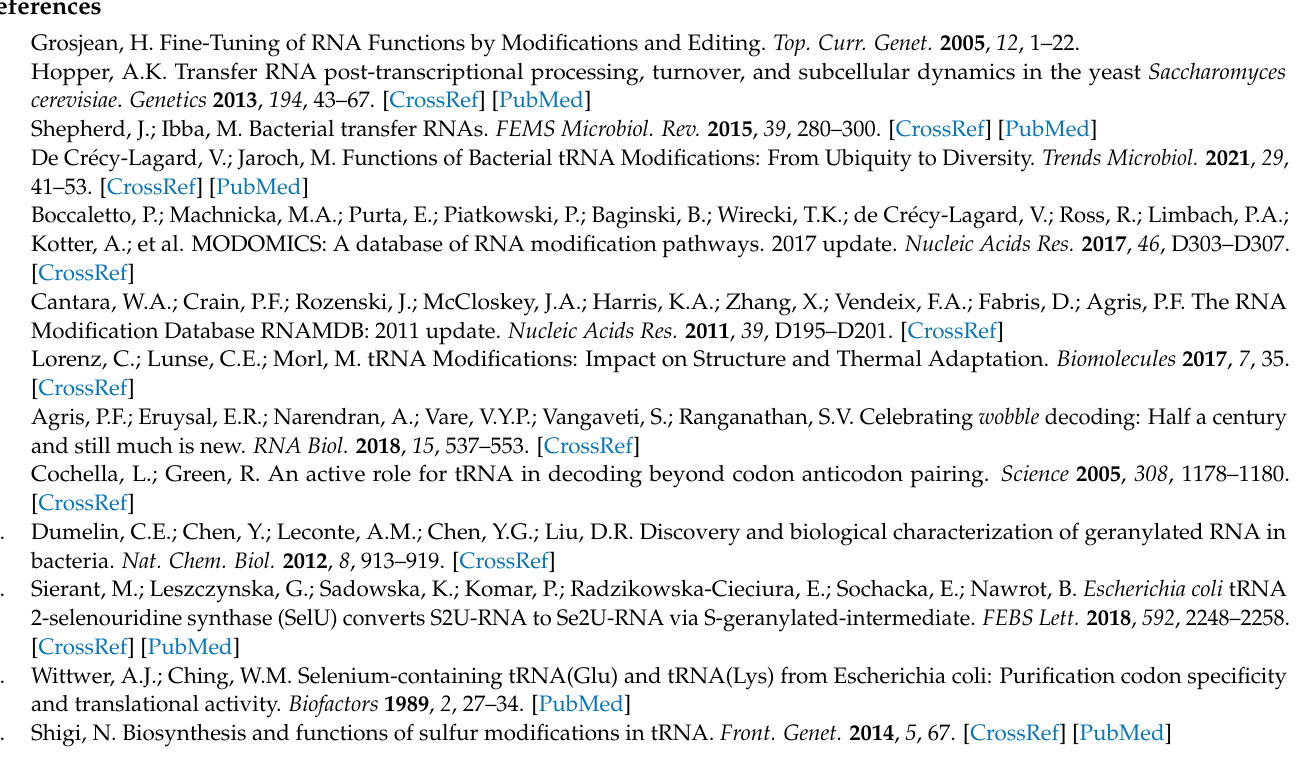
catalyzed by MBP-SelU, Table S4: MST Dataset Overview, Table S5: Calculation of the molecular formula and molecular weight of the bacterial tRNALys, tRNAGlu and tRNAGln depending on nucleoside modification at the wobble position, Table S6: Qualitative analysis of modified nucleosides present in the wobble position of tRNAs associated with MBP-SelU protein, results of UPLC-PDA-ESI (-)-HRMS measurements, Table S7: Results of UPLC-PDA-ESI(-)-HRMS measurements, identification of additional (present in a position other than the wobble) modified nucleosides in the bacterial tRNAs specific for Lys, Glu and Gln associated with the MBP-SelU protein, Synthetic Procedures and Protein